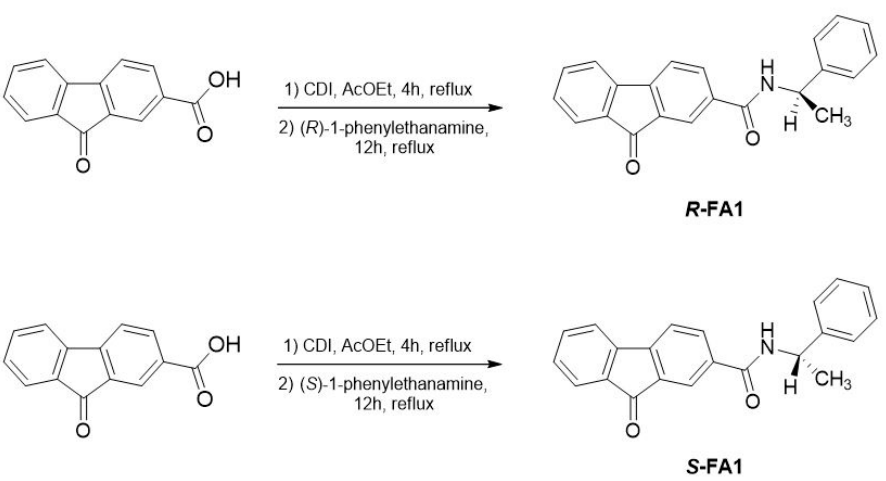
Figure 1. Chemical synthesis of enantiomeric amide compounds ( R -FA1 and S -FA1).